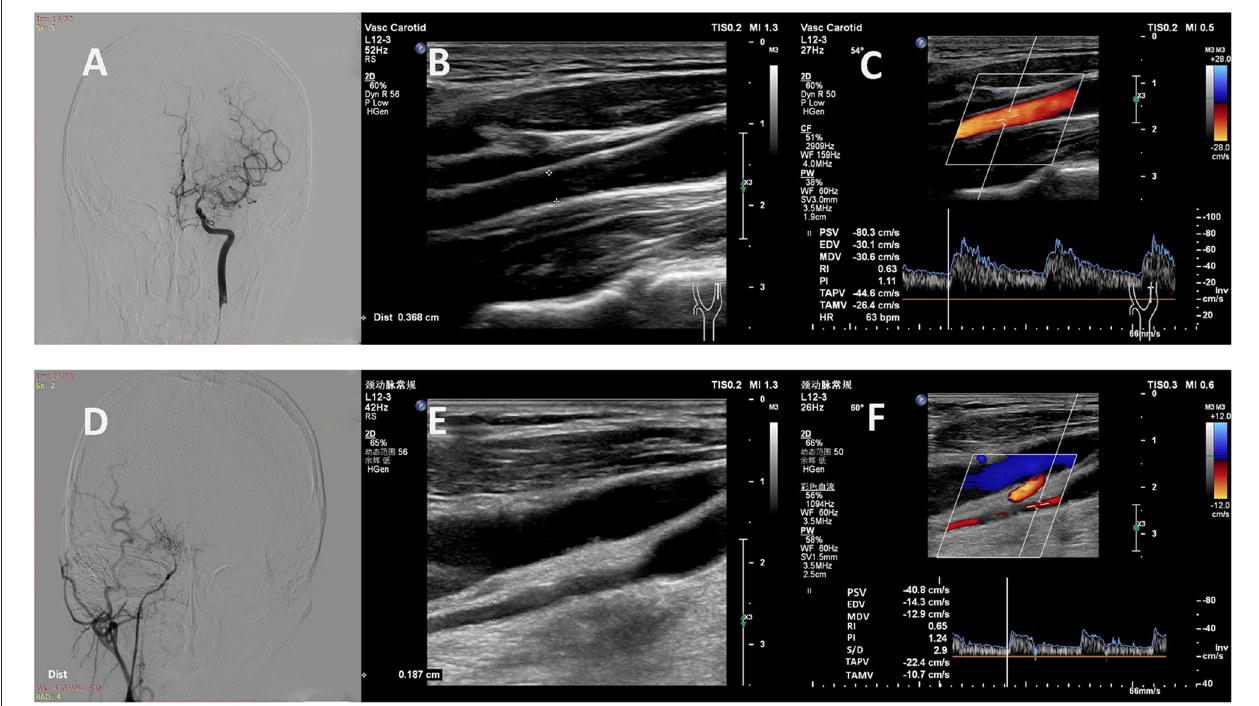
FIGURE 3 | Representative cases. (A) A 32-year-old man with MMD had a Suzuki stage II on the left. (B, C) Carotid ultrasound showed high values of D (0.37cm), PSV (80 cm/s), EDV (30 cm/s), TAMV (26 cm/s) and FV (168 ml/min) in the left EICA. (D) A 37-year-old woman with MMD had a Suzuki stage V on the right. (E, F)